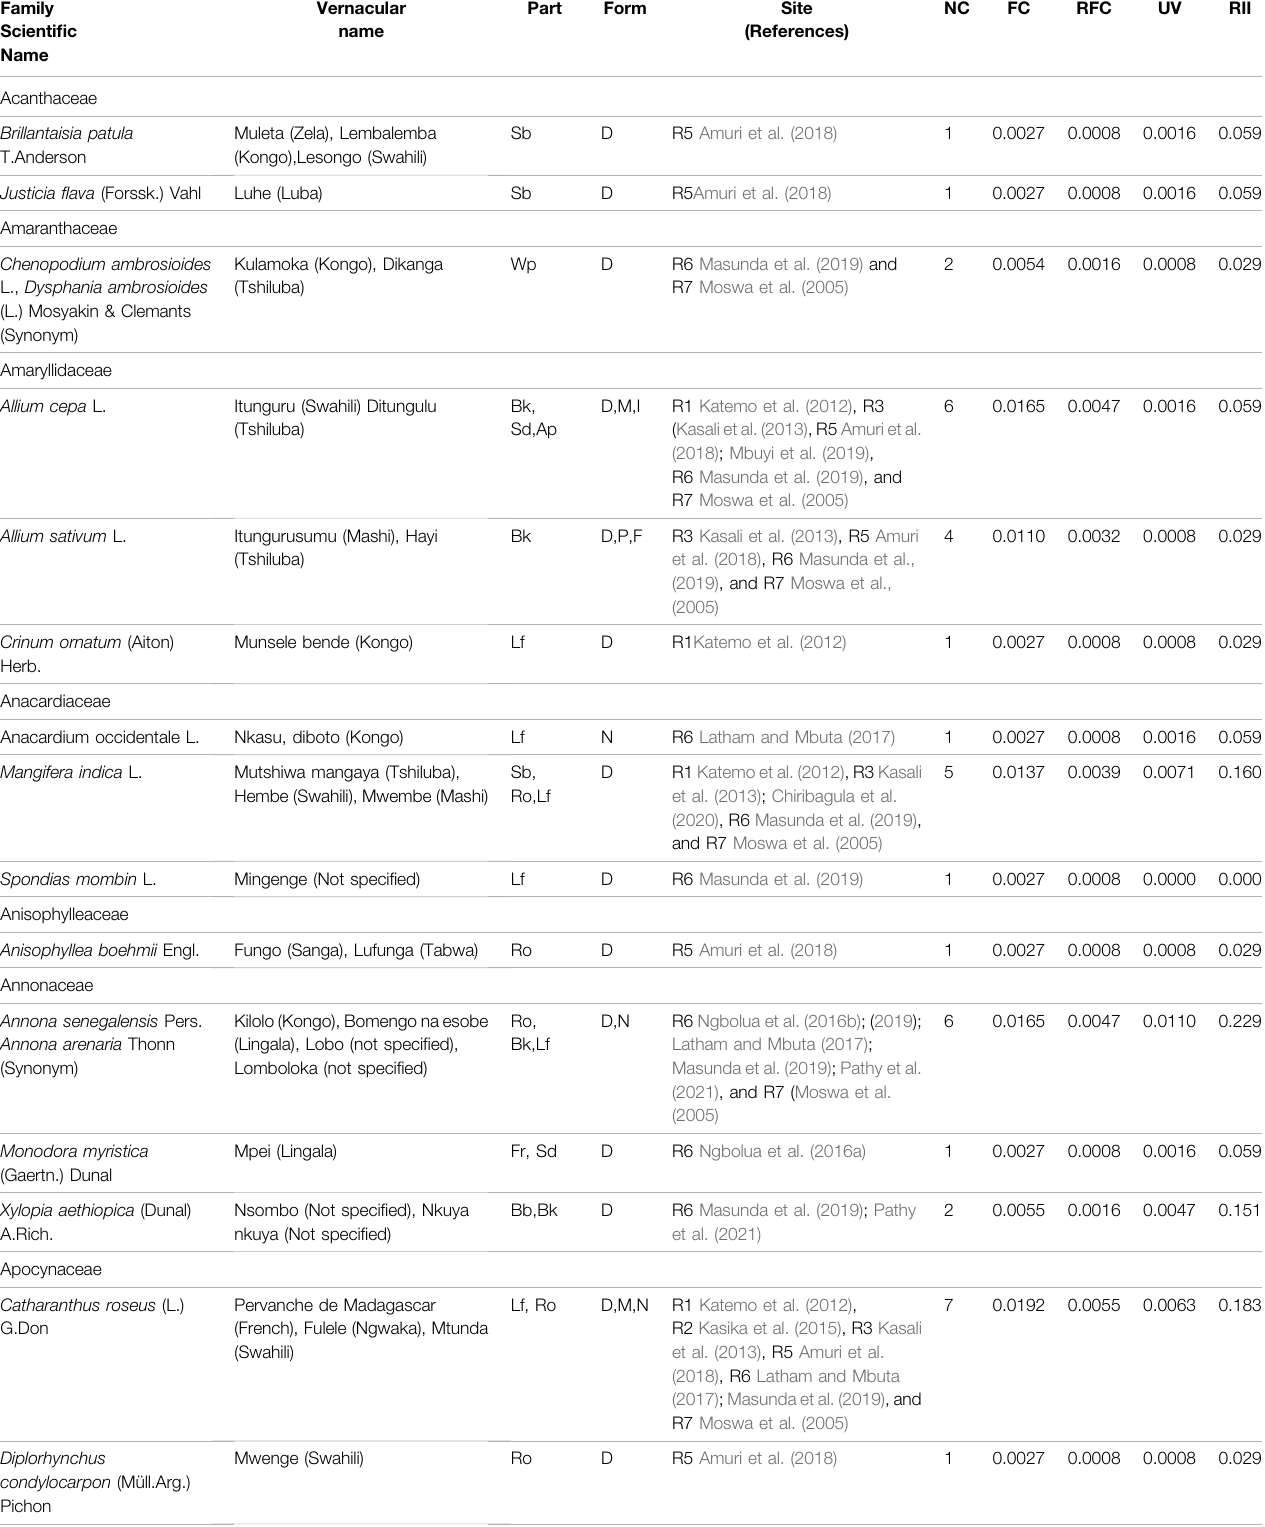
TABLE 1 | Ethnopharmacological speci fi cations of plant species used to treat diabetes in